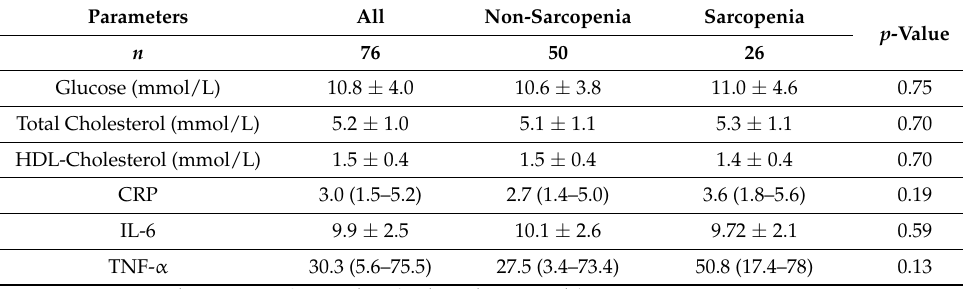
Table 4. Biochemical analysis according to sarcopenia status.